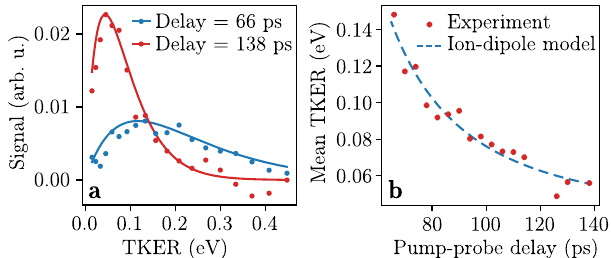
Fig. 4 | Evolution of the total projected kinetic energy release. a TKER dis- tributions forpump-probe delays of 66 ps(blue)and 138 ps (red). Thedots arethe experimental distributions after subtracting the mean TKER distribution for negative pump-probe delays, whereas the solid lines show fi tted statistical dis- tributions. b Mean TKER values obtained from the experimental distributions (red dots) and a fi t through these data points (blue dashed line) based on an ion-dipole interaction model, see the text for